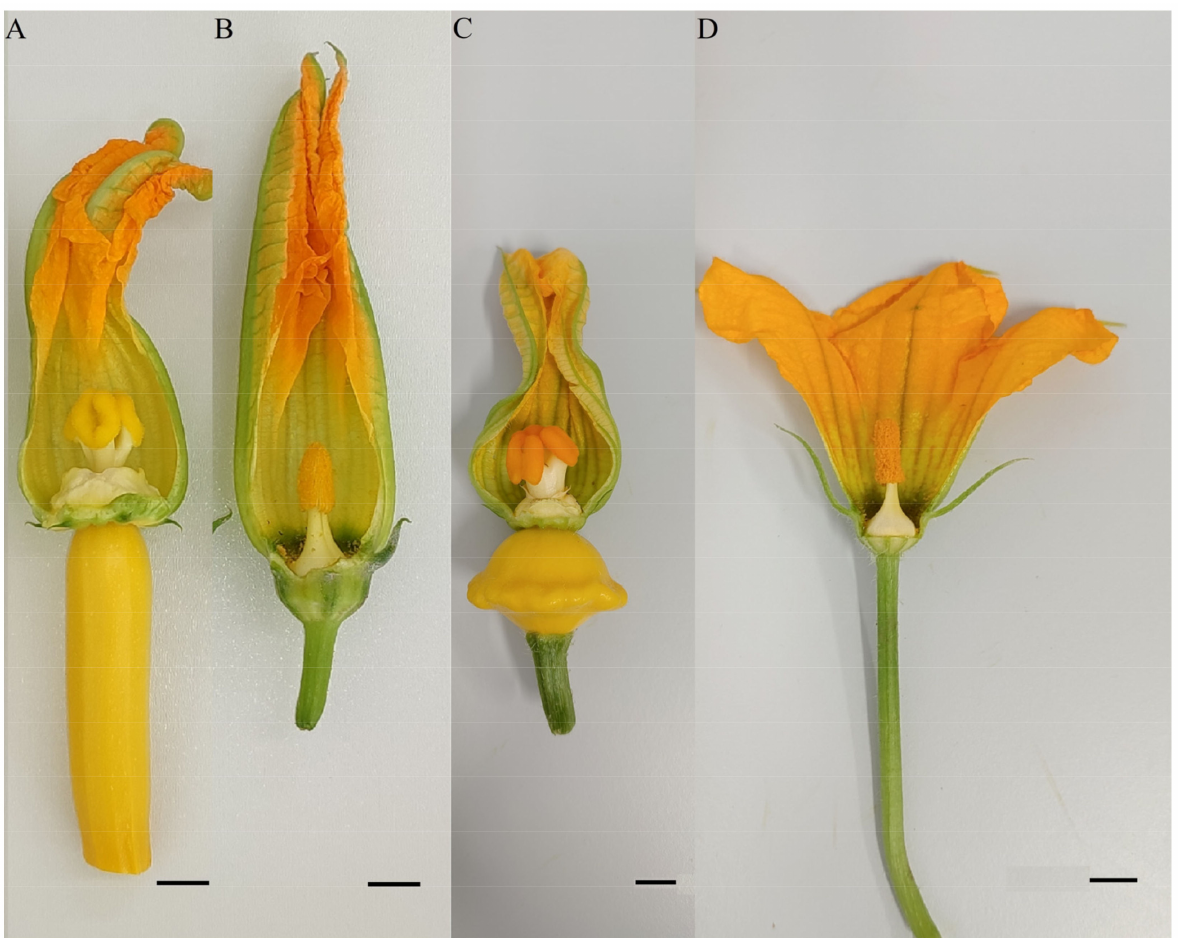
Figure 2. Normal flowers of C. pepo : ( A ) female flower of courgette; ( B ) male flower of courgette; ( C ) female flower of patisson; ( D ) male flower of patisson. Scale bars = 1